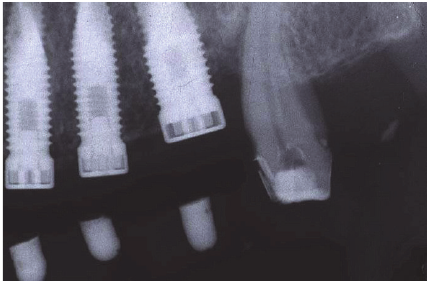
Figure 27: A second stage was performed 5 months after implant surgery.